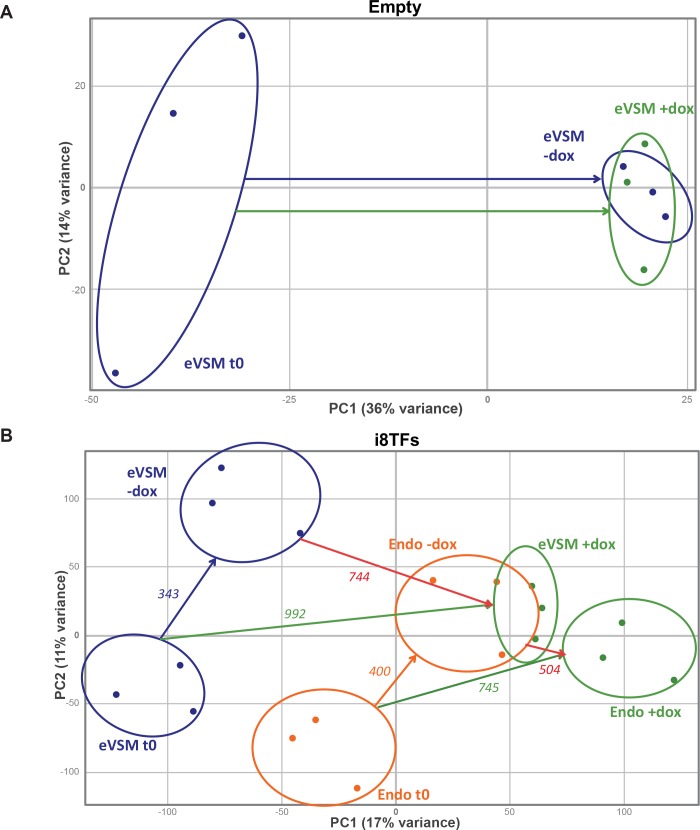
PCA plots of microarrays data.(A) PCA plot showing the microarray analysis results from the eVSM after 24 hr of dox treatment on the Empty cell line. Ellipses indicate the different groups of samples. (B) PCA plot showing the microarray analysis results from the indicated conditions after 24 hr of dox treatment on the i8TFs ESC line. Numbers indicate the number of genes significantly differentially expressed between the two conditions (p-value<0.05). Ellipses indicate the different groups of samples. See also Supplementary file 11.